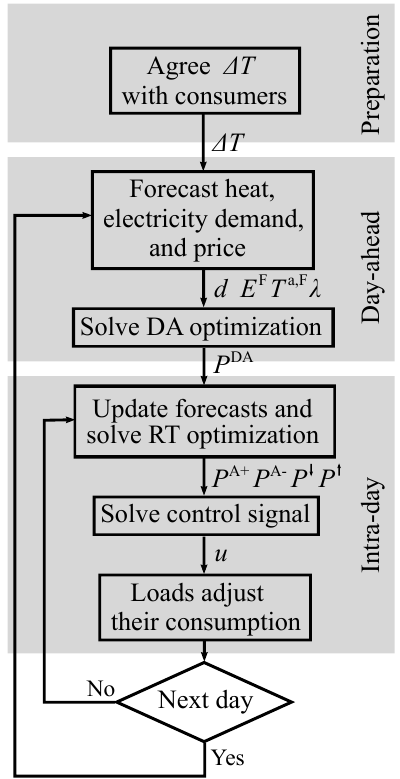
Figure 1. Flowchart of the control strategy. The notation correspond to the notation of day-ahead (DA) and real-time (RT) optimization